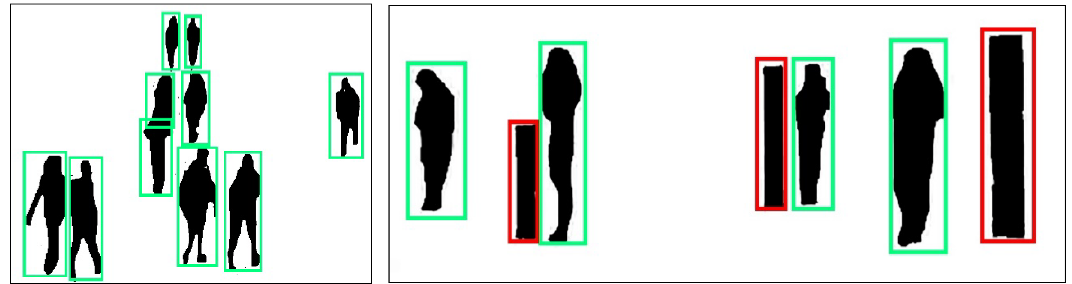
Figure 4. Human verification results over video-based datasets. The red bounding box indicates non-human objects, whereas the green bounding box indicates a human silhouette.